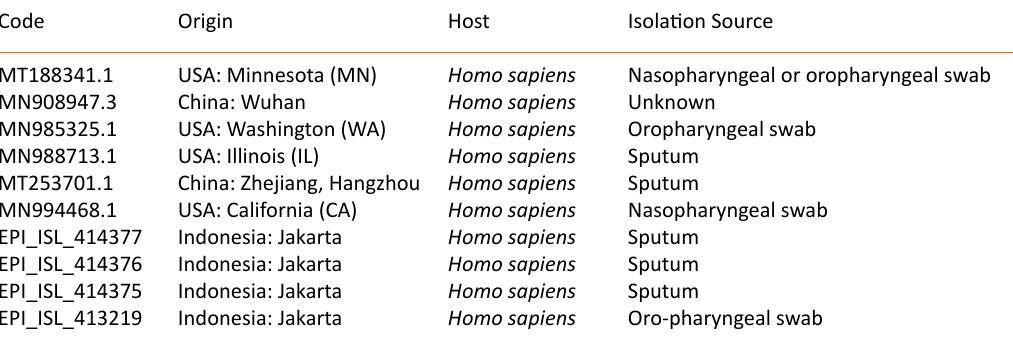
Table 1. SARS-CoV-2 and other CoV isolates from the NCBI and GISAID databases